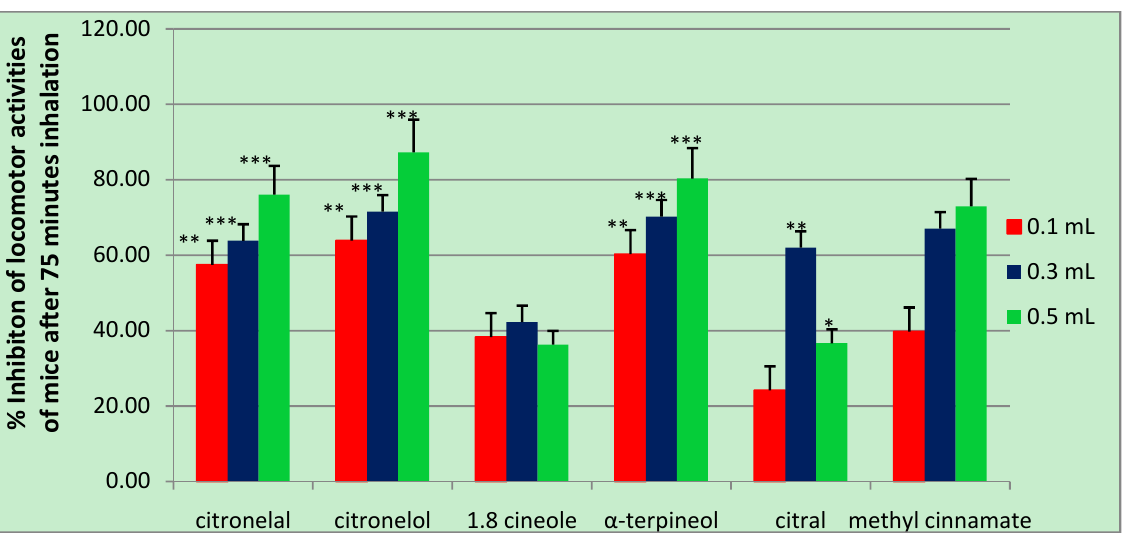
Figure 3. Bar graphs of the average number of locomotor activities of mice after 75 min inhalation of single detected